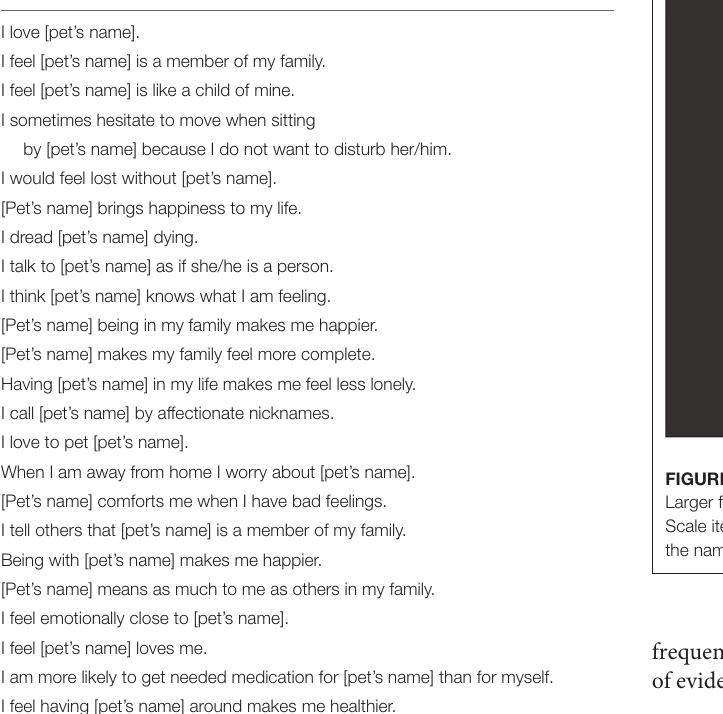
TABLE 1 | Bonded family scale items.